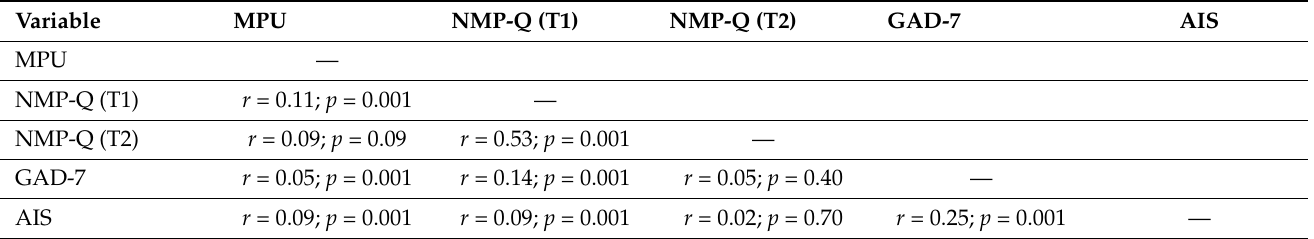
Table 3. The association between study variables.